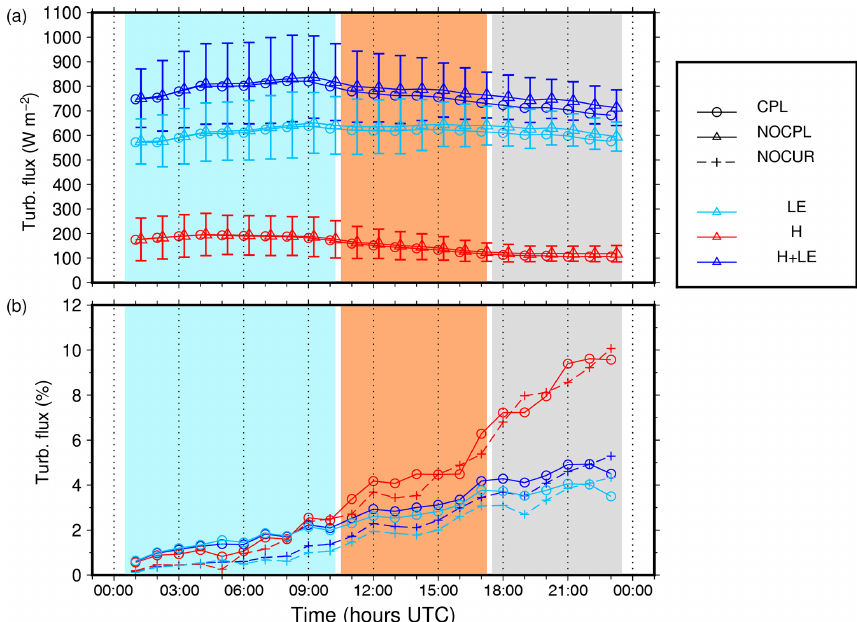
Figure 9. Time series of the mean values and standard deviations (error bars) of the total turbulent heat flux (blue), latent heat flux (cyan) and sensible heat flux (red) in the CPL (open circles) and NOCPL (triangles) simulations (a) and of the mean difference between CPL and NOCPL turbulent fluxes (open circles; same colour code) and between NOCUR and NOCPL turbulent fluxes, in percentage relative to the NOCPL values (b) in the EF600